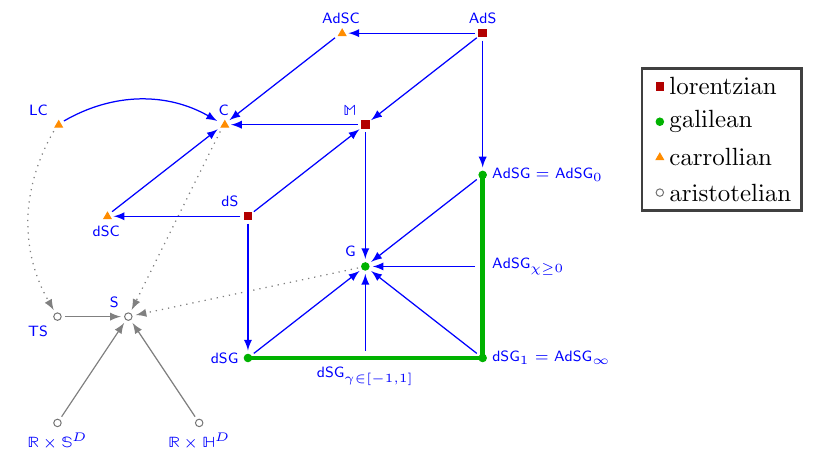
Figure 1 . Homogeneous spacetimes in dimension D + 1 (cid:21) 4 and their